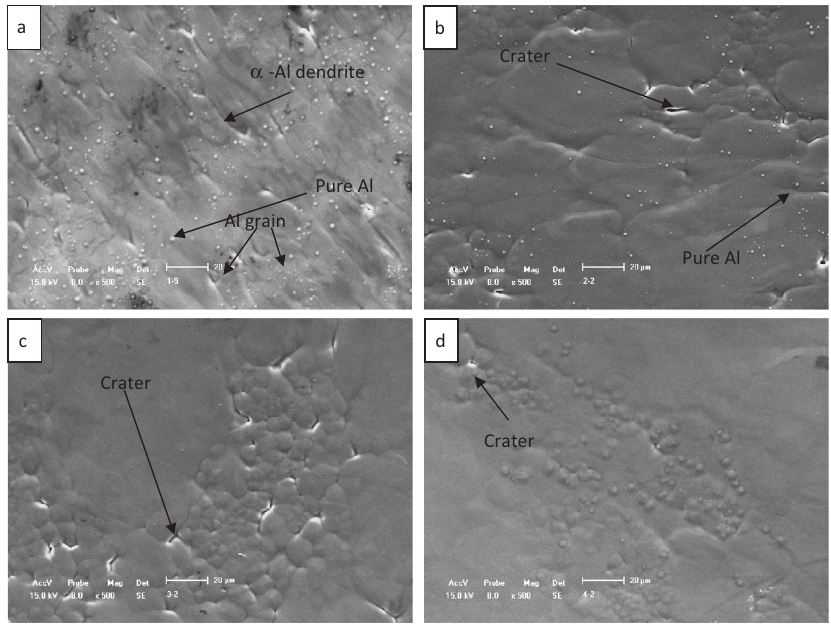
Figure 2: Surface SEM image of HCPEB- treated hypoeutectic Al – 10Si alloy under different pulse numbers: (a) 5 pulses, (b) 15 pulses, (c) 25 pulses and (d) 35